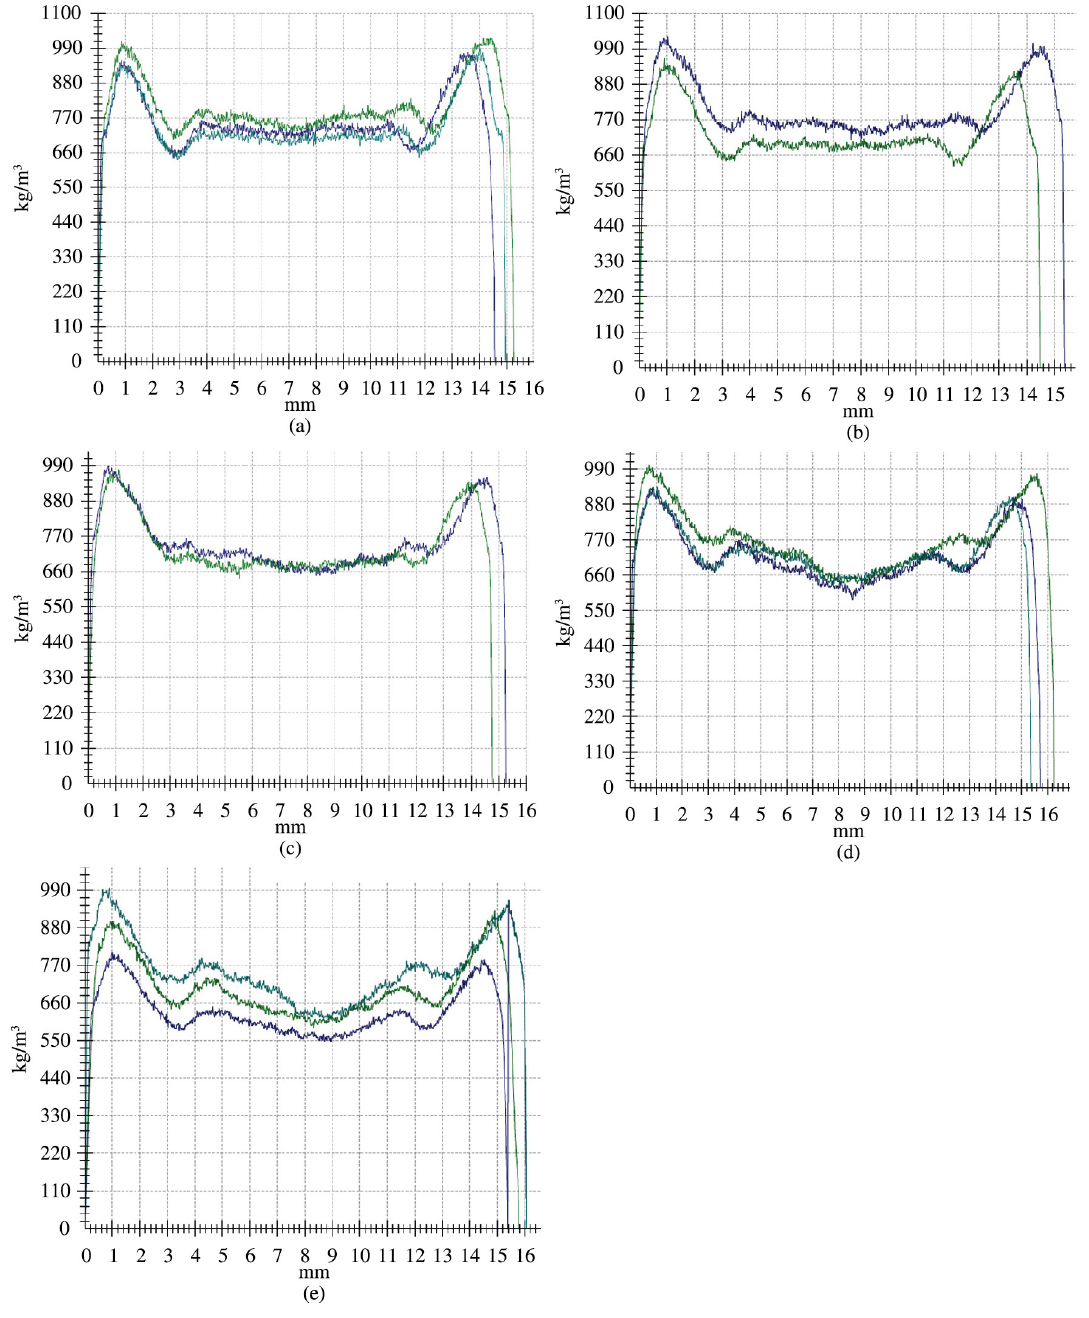
Figure 3. Density profiles along the panels thickness, step A with 14% resin. (A) 100% eucalyptus, (B) 25% bagasse and 75% eucalyptus (C) 50% bagasse and 50% eucalyptus, (D) 75% bagasse and 25% eucalyptus; (E) 100%